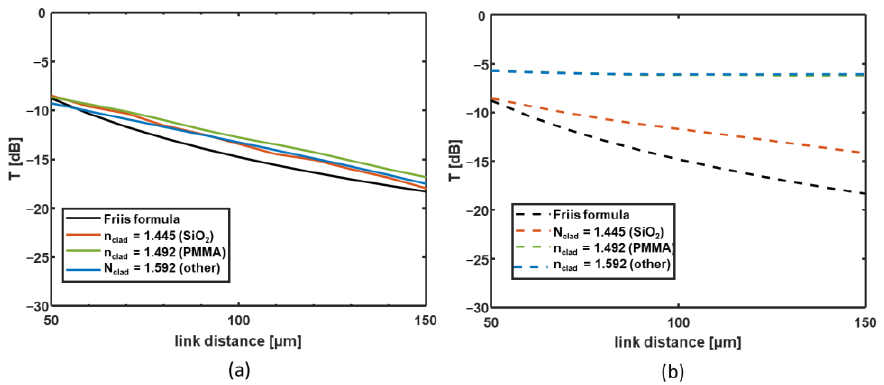
Figure 14. Transmittance in dB, which is calculated at the receiver waveguide as a function of the link distance for different values of the cladding refractive index: ( a ) TE and ( b ) TM polarizations. The black curves denote the transmittance calculated by the Friis transmission equation for a point-to-point link in a homogeneous medium (with refractive index n SiO2 = 1.445). The cladding thickness is d = 3 µm, and the wavelength is λ = 1.55 µm.